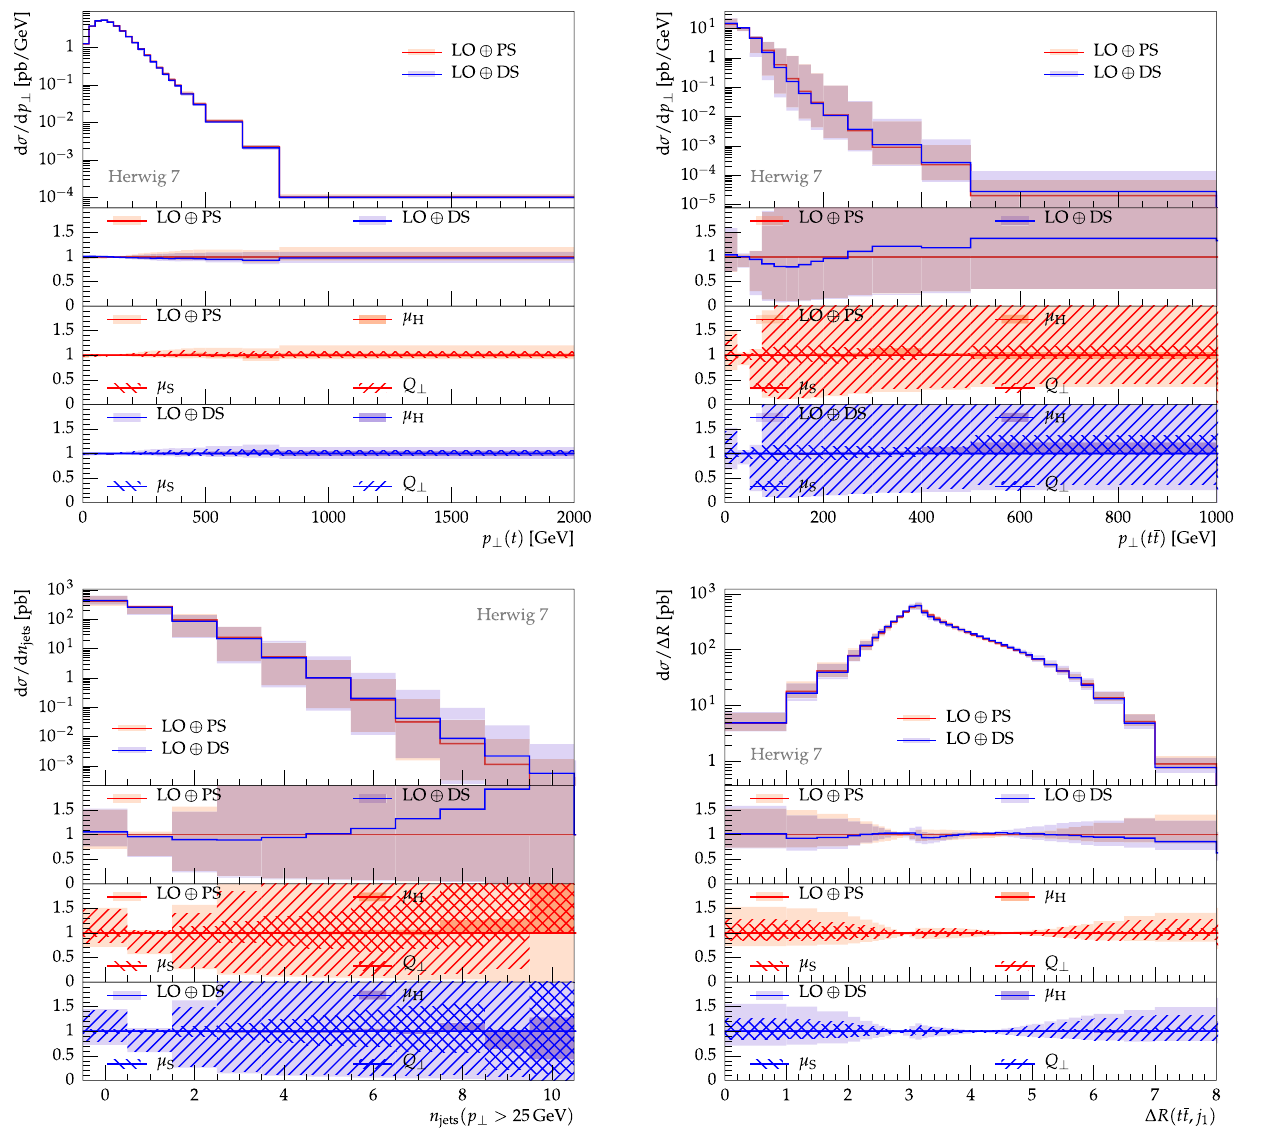
angular-ordered shower. The bottom two ratio plots in each plot show, for the angular-ordered and dipole showers respectively, a breakdown of all variations into variations of the (factorization and renormaliza- tion) scale in the hard process ( μ H ), of the arguments of the running coupling and PDFs in the shower ( μ S ) and of the hard veto scale ( Q ⊥